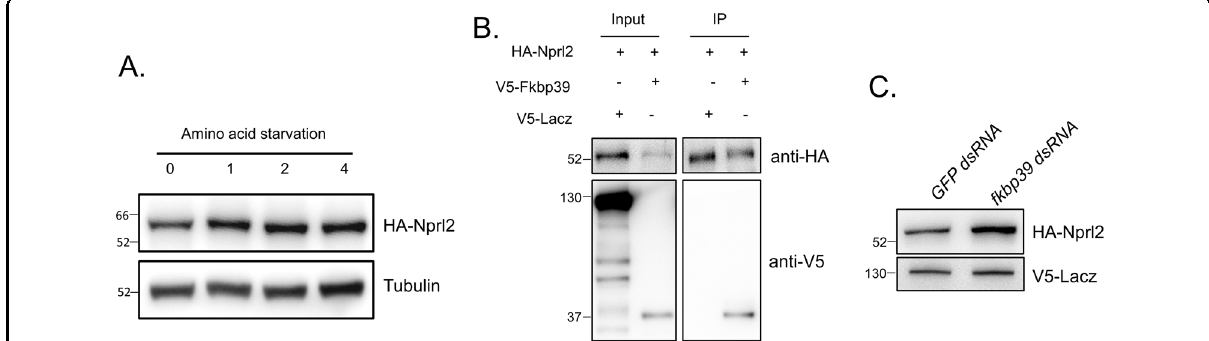
Fig. 4 FKBP39 associates with Nprl2 and decreases its expression. A S2 cells were transfected with the indicated construct inserted with HA- tagged Nprl2 coding region. The cells were starved for the indicated time and the HA-Nprl2 levels were measured by western blot. α -Tubulin was used as a loading control for western blot. B S2 cells were co-transfected with HA-tagged Nprl2 and V5-tagged FKBP39 or lacZ (control) plasmids. Cells were lysed and immunoprecipitated using beads coated with anti-HA antibody. Cell lysates (inputs) and immunoprecipitates (IP) were detected by western blot. C S2 cells were co-transfected with the GFP (control) or fkbp39 dsRNA, constructs expressed HA-tagged Nprl2 and V5-tagged lacZ. The levels of HA-Nprl2 and V5-lacZ were detected by western blot. V5-lacZ was used as a loading control for western blot. Similar western blot results were observed in more than three independent experiments for each